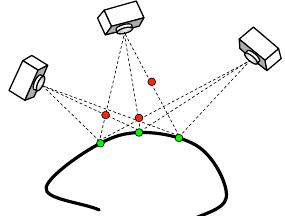
Figure 4: Rogue points (red) can be identified as occlusors of actual surface points (green). In order to avoid any loss of accuracy, a moving average approach have been used inside each bin. At the end of the lifting pro-